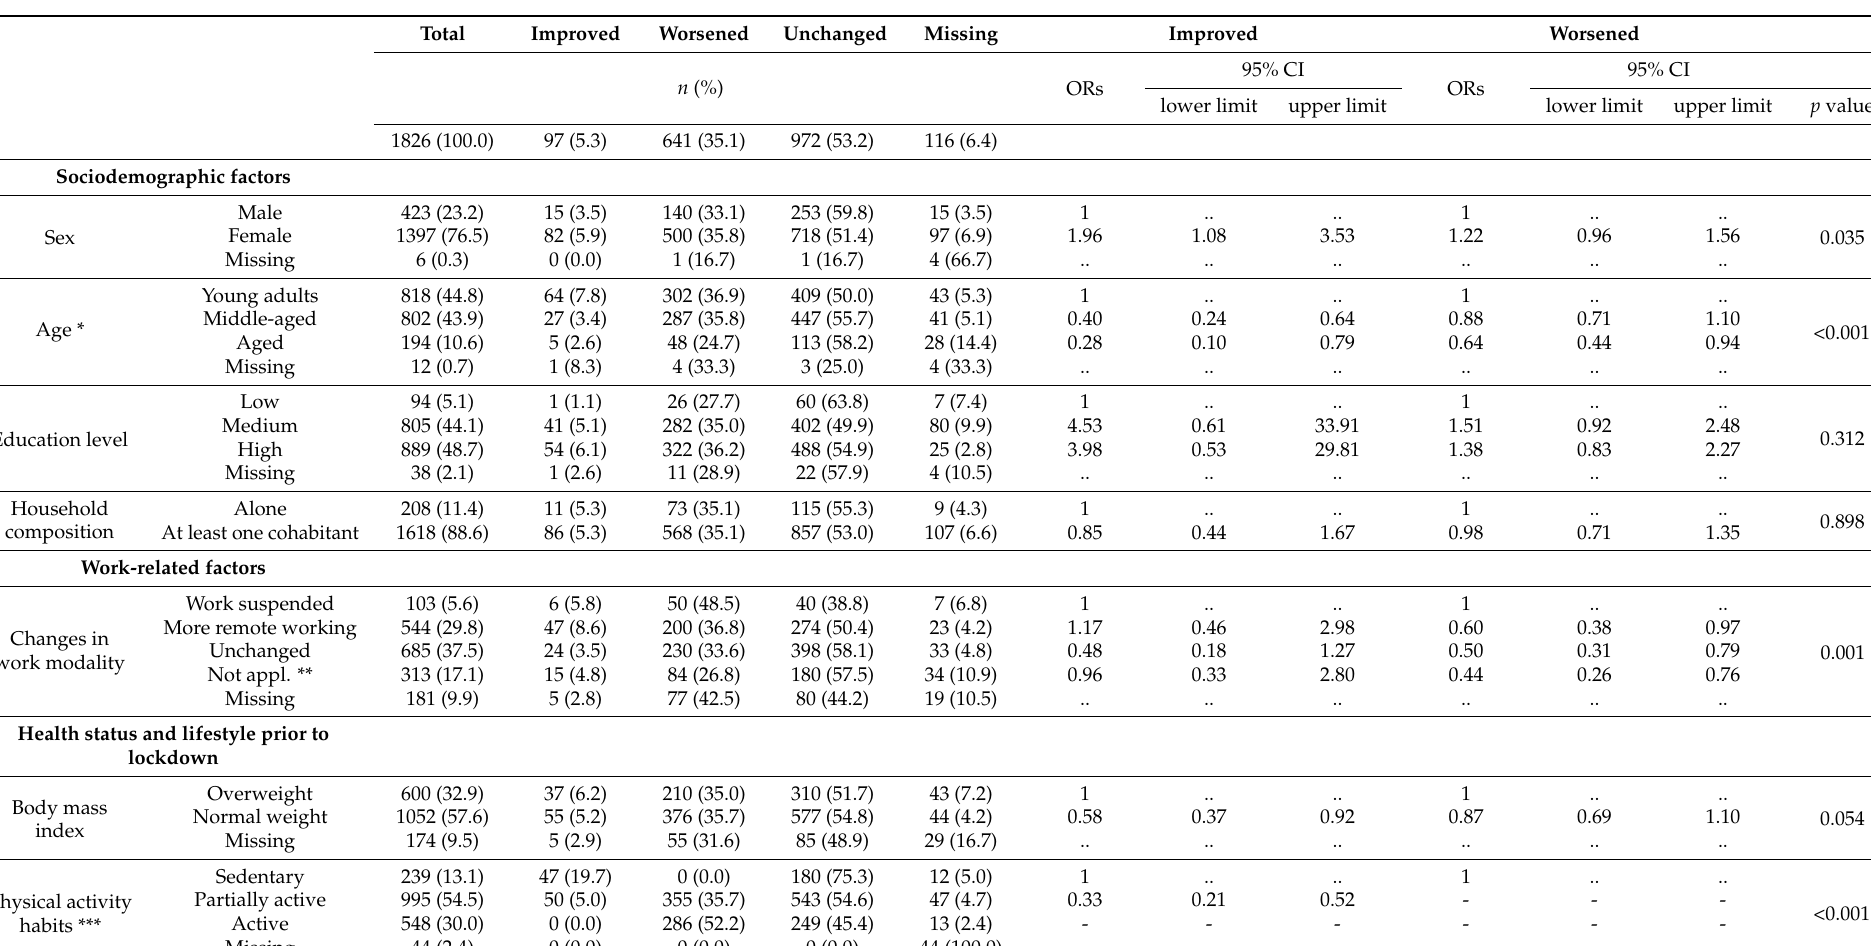
Table 2. Odds ratio for type of change in physical activity (improved, worsened, or unchanged) during COVID-19 lockdown by sociodemographic and work-related factors, health status, and lifestyle prior to lockdown, and psychological